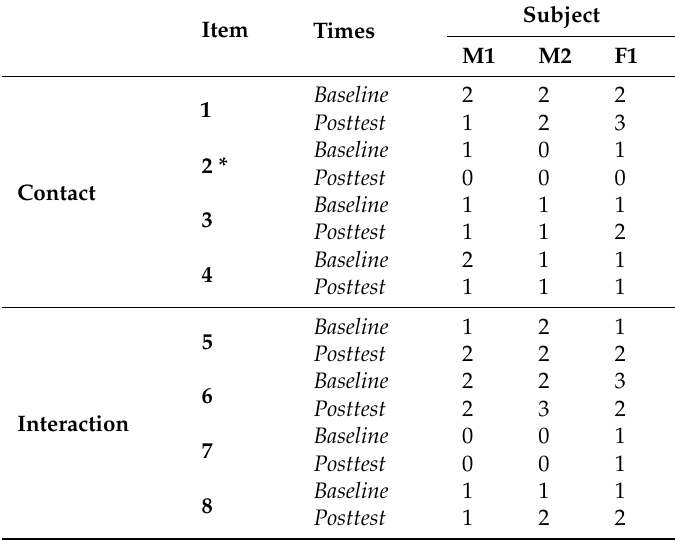
Table 4. Frequencies of social behaviors targeting contact and interaction before and after the aquatic adapted physical activity program. Item